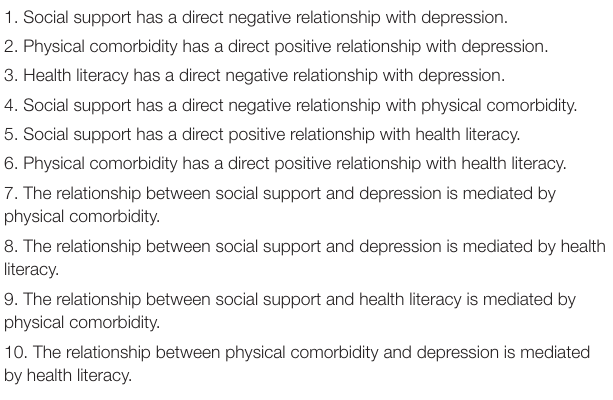
TABLE 1 | The theoretical hypotheses.